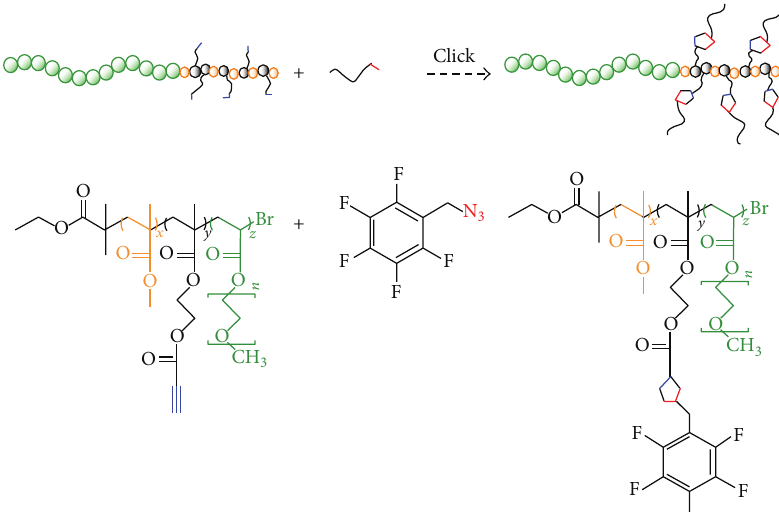
Figure 1: Schematic illustration of click coupling between PEGMA based amphiphilic block copolymers bearing pendant clickable sites and azide-functional